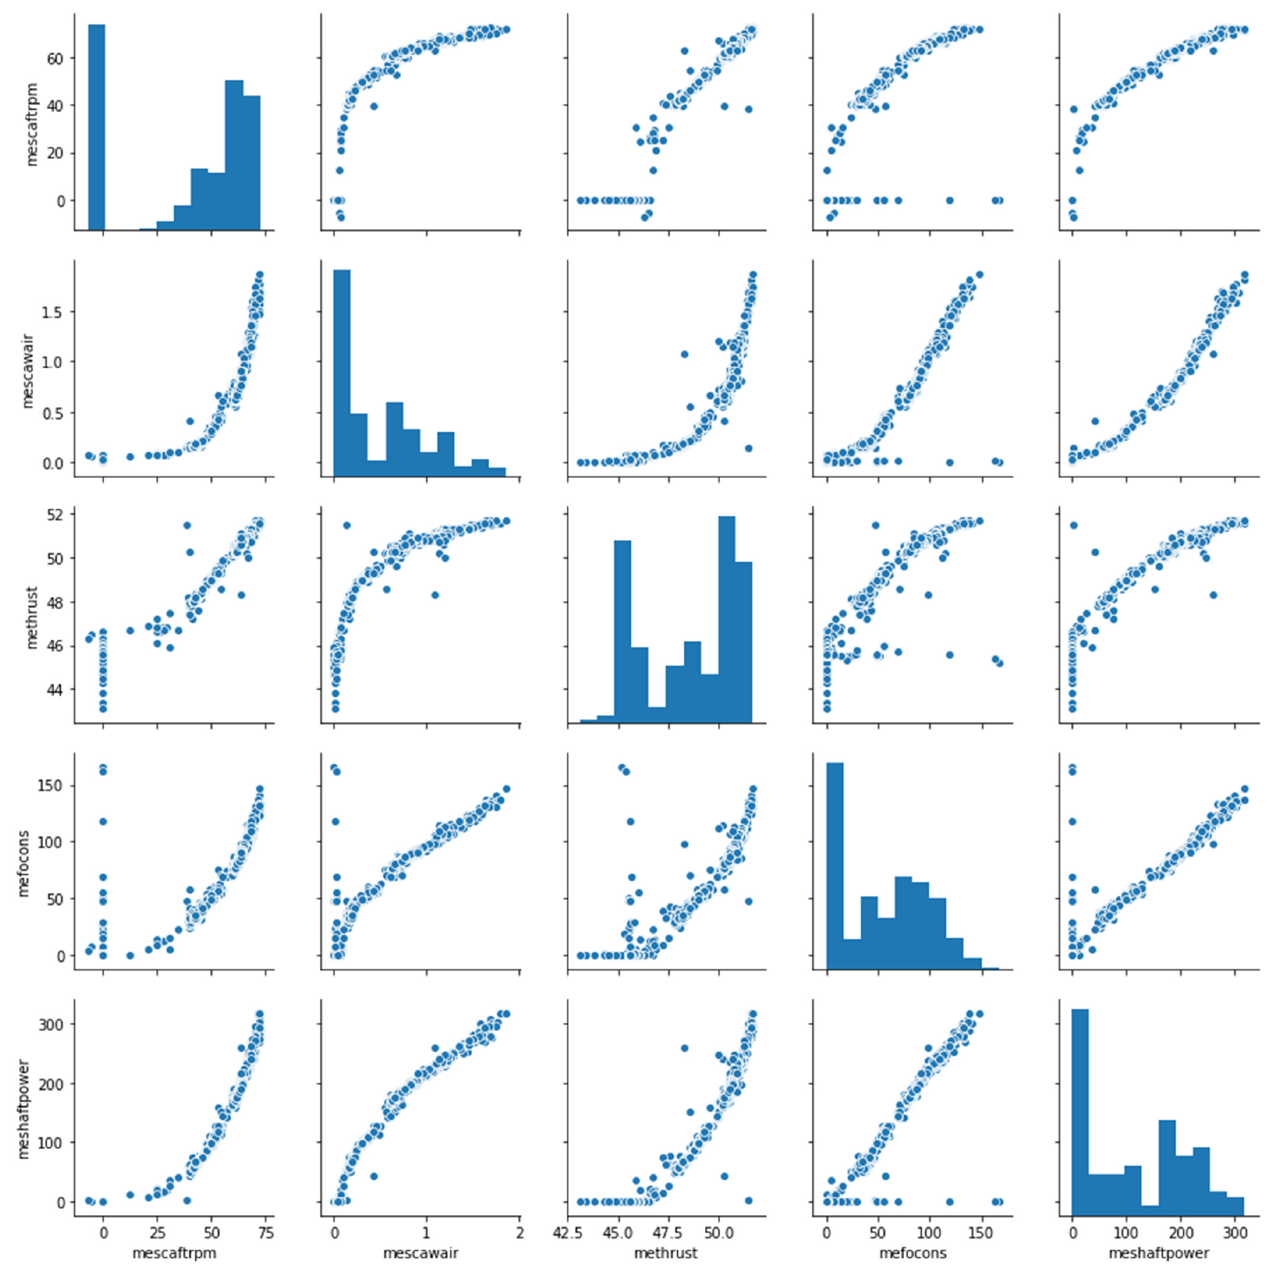
Figure 4. Strongest correlation variables with power and fuel consumption variables.